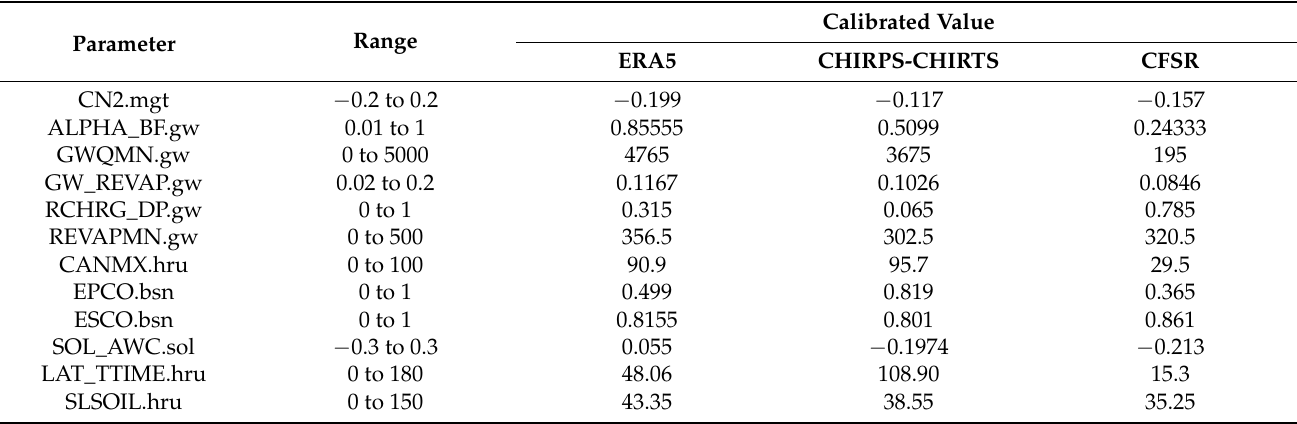
Table 4. Calibrated parameter